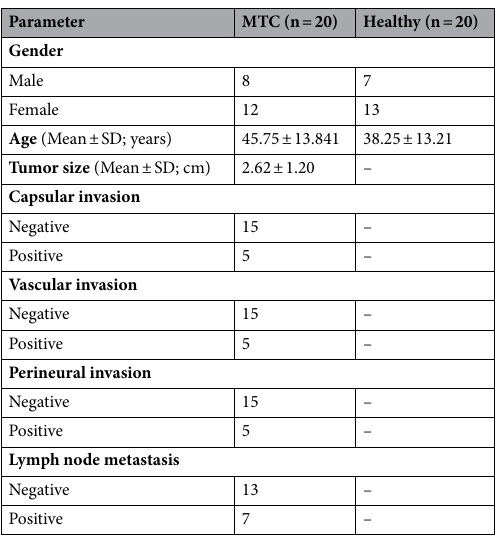
Table 1. Demographic and clinicopathological characteristics of the study subjects. MTC medullary thyroid